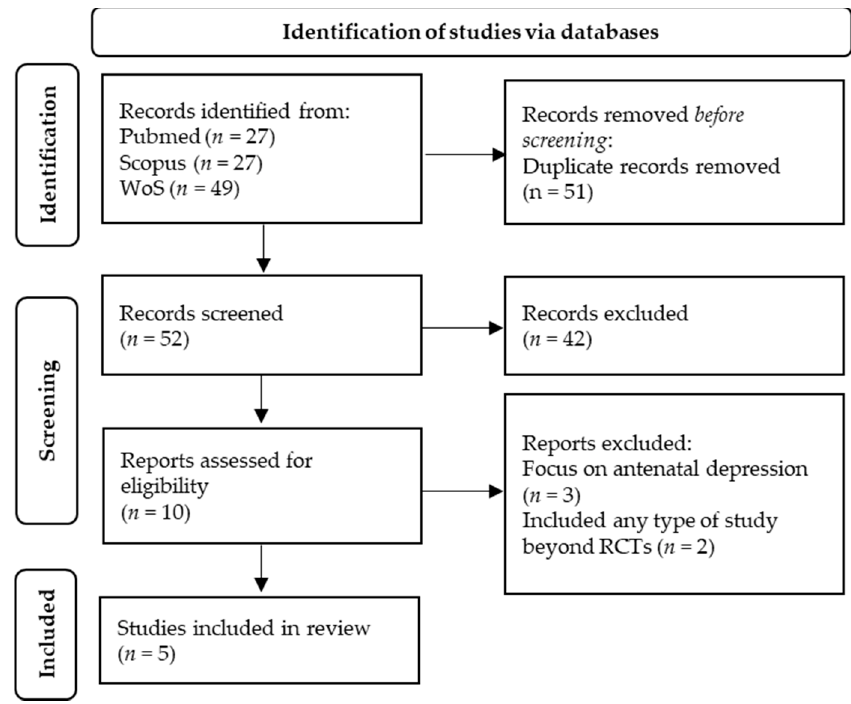
Figure 1. Preferred Reporting Items for Systematic Reviews and Meta-analysis (PRISMA) flow diagram of the search and selection process for the meta-analyses included in the current study.